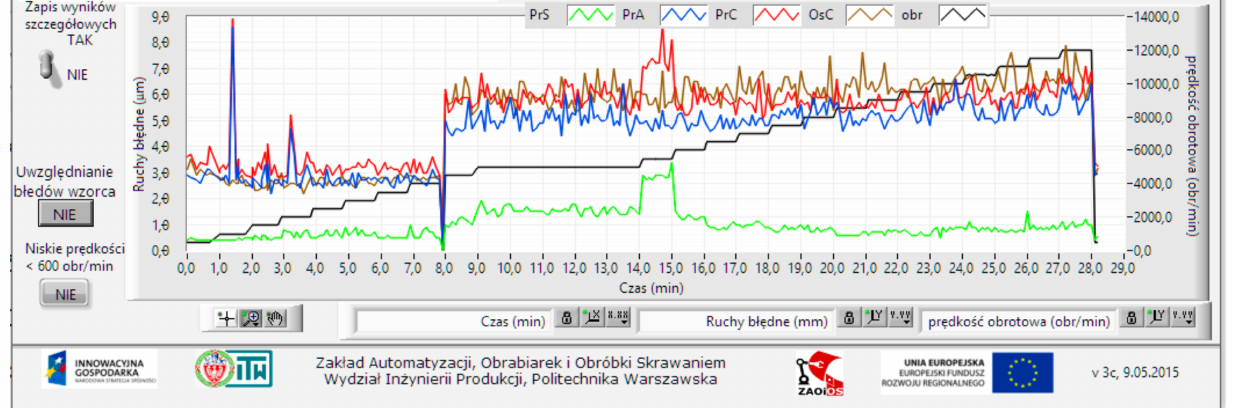
Figure 70. Distribution of values of spindle error movements at different spindle rotational